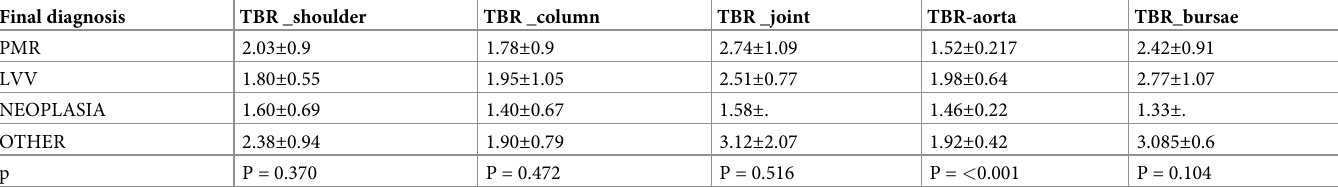
Of the five patients who were finally diagnosed with neoplastic processes (four haematological and one transverse colon) and who first presented with PMR, the 18 FDG-PET/CT scan showed Table 2. TBR of the different locations according to the final